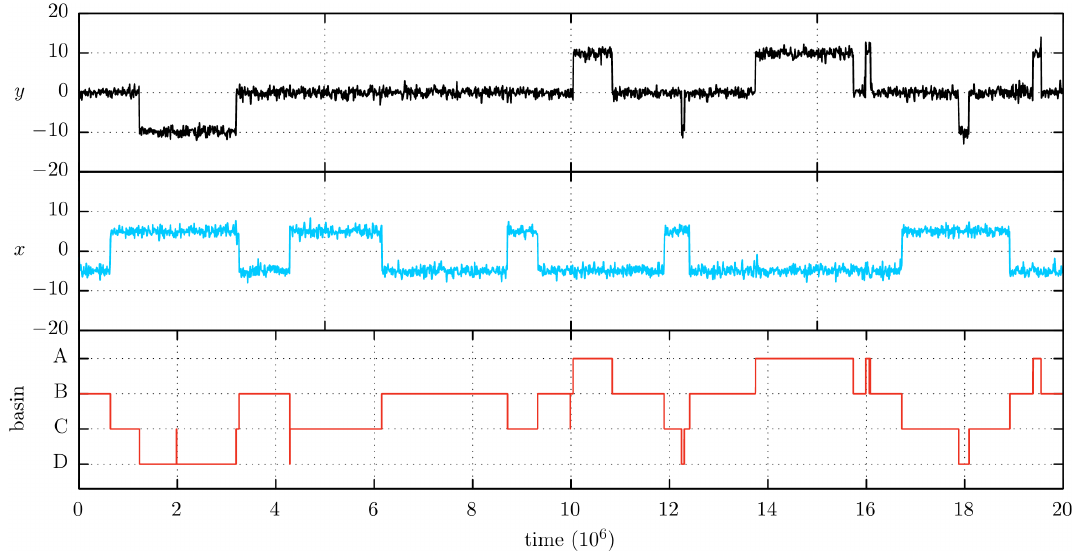
Figure 2. MD trace for the PES show in Figure 1 at k B T = 1.19. The x and y coordinates are plot are the top (black) and middle panel (blue) respectively. The bottom panel (red) shows the basin assignation using a Voronoi tessellation for the PES minima and a running average of 5 time units as is explained in the